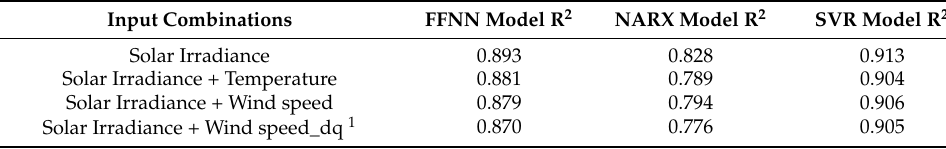
Table 1. R 2 results of the input combinations tested.